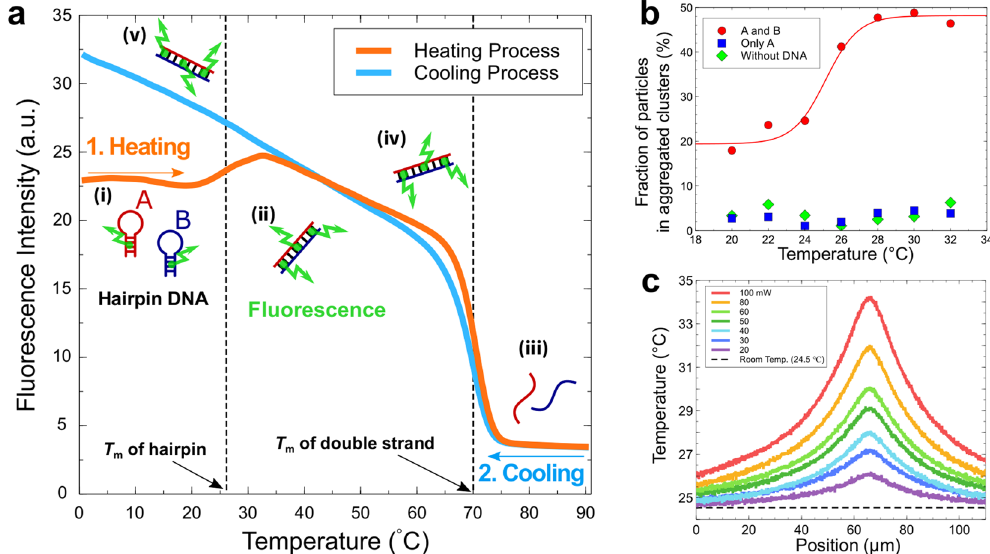
Figure 2. Temperature properties and temperature distribution. ( a ) Melting curve of the hairpin DNA strands. DNA strands A and B are suspended in the presence of EvaGreen, which is a fluorescent dye specific for double-stranded DNA. The fluorescent intensity indicates the amount of the double helices in the solution. The solution was heated from 0 °C to 90 °C and then cooled down to 0 °C. (i) A and B form hairpin-loop structures separately below T m,hairpin = 26°C. (ii) When heated above T m,hairpin , the hairpin structures unfold, and A and B form double strands. (iii) At T > T m,ds = 70 °C, the double strands denature, and fluorescence decreases. (iv) When cooled down below T m,ds , double strands form again. (v) When cooled down even below T < T m,hairpin , the double strands remain formed. ( b ) Aggregation test with 2 μ m DNA-colloidal particles. The particle suspension (2.0%v/v) was kept at 1 °C and then heated to the specified temperatures and incubated for 1 minute. After it was cooled down to 1 °C and diluted to 1/50, the particle aggregation was observed under a microscope. Some particles formed an aggregated cluster containing various number of particles. The number fractions of the particles in aggregated clusters are plotted. Because it was difficult to count the number of particles in a large cluster, we recorded the number of particles as four for the clusters containing four or more particles. This did not affect the qualitative result. We plotted the fraction of the particle numbers of the aggregated clusters in the suspension for both particles A and B (circles), only particles A (squares), and particles without DNA strands (diamonds). The solid curve is a fitting by a Tanh function. ( c ) Temperature distribution around the focused laser spot in the chamber filled with a buffer. At the laser focal point, the temperature was locally heated up to 9 °C according to the laser power. The temperature profile was well fitted by a Lorentzian curve (data not shown) as reported in the previous studies 25, 34 , validating our method of the local heating and the temperature